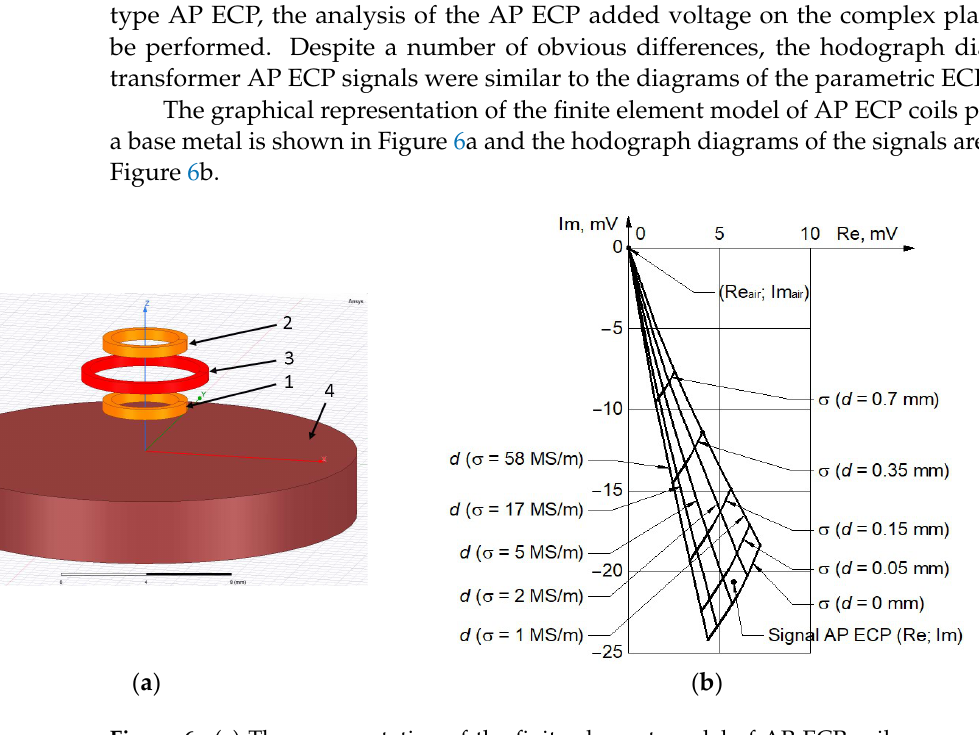
Figure 6. ( a ) The representation of the finite element model of AP ECP coils over a base metal, ( b ) hodograph diagrams of the signals of the AP ECP finite element model. 1—measuring coil, 2—com- pensating coil, 3—excitation coil, 4—base